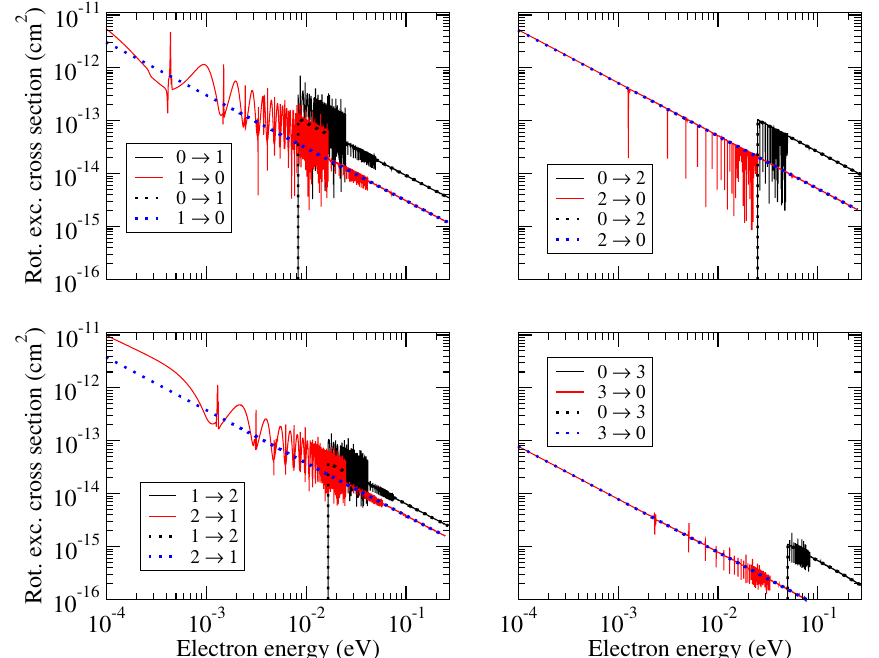
Figure 1. Rotational (de-)excitation cross sections for transitions between the four lowest rotational states of HeH + . Solid lines represent the results obtained with the applied closed-channel elimination procedure of Equation (A14), while the dotted lines show the results for which the procedure was not applied.